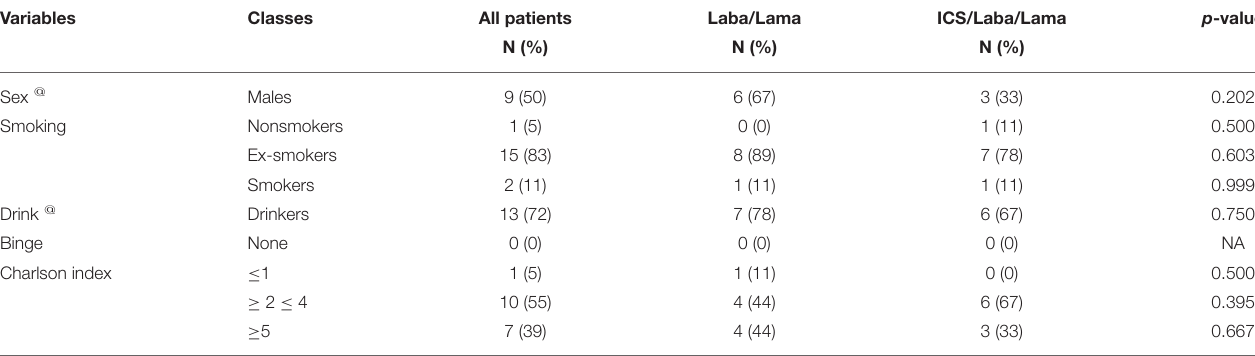
TABLE 2 | Distribution of categorical variables in COPD patients with p -values of the chi-square test comparing the two